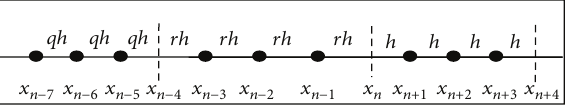
Figure 1: 4-point block